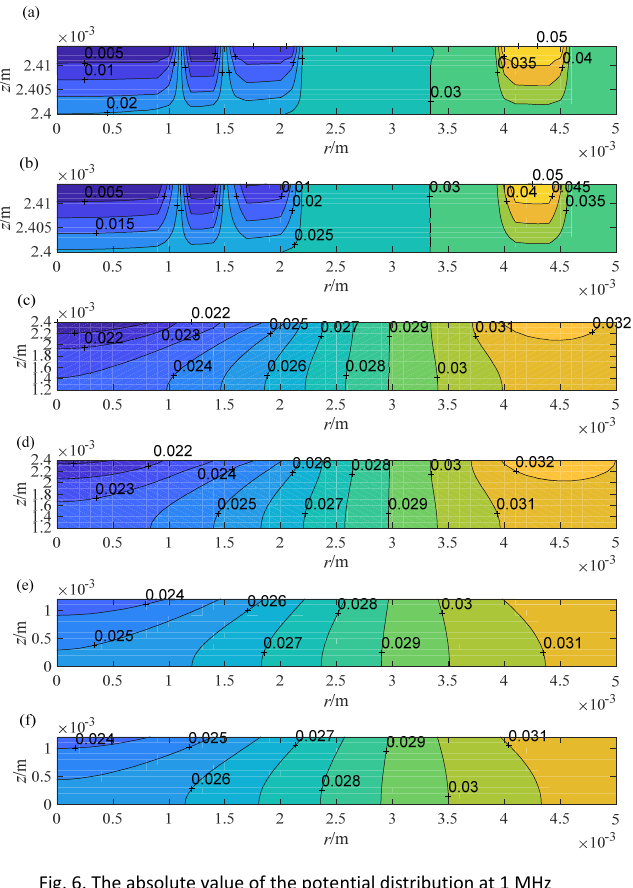
Fig. 6. The absolute value of the potential distribution at 1 MHz for n=3 and m=4: The numerical solution of the full set of equations for SC (a), VS (c), and AT (e); and approximate semi- analytical solution for SC (b), VS (d) and AT